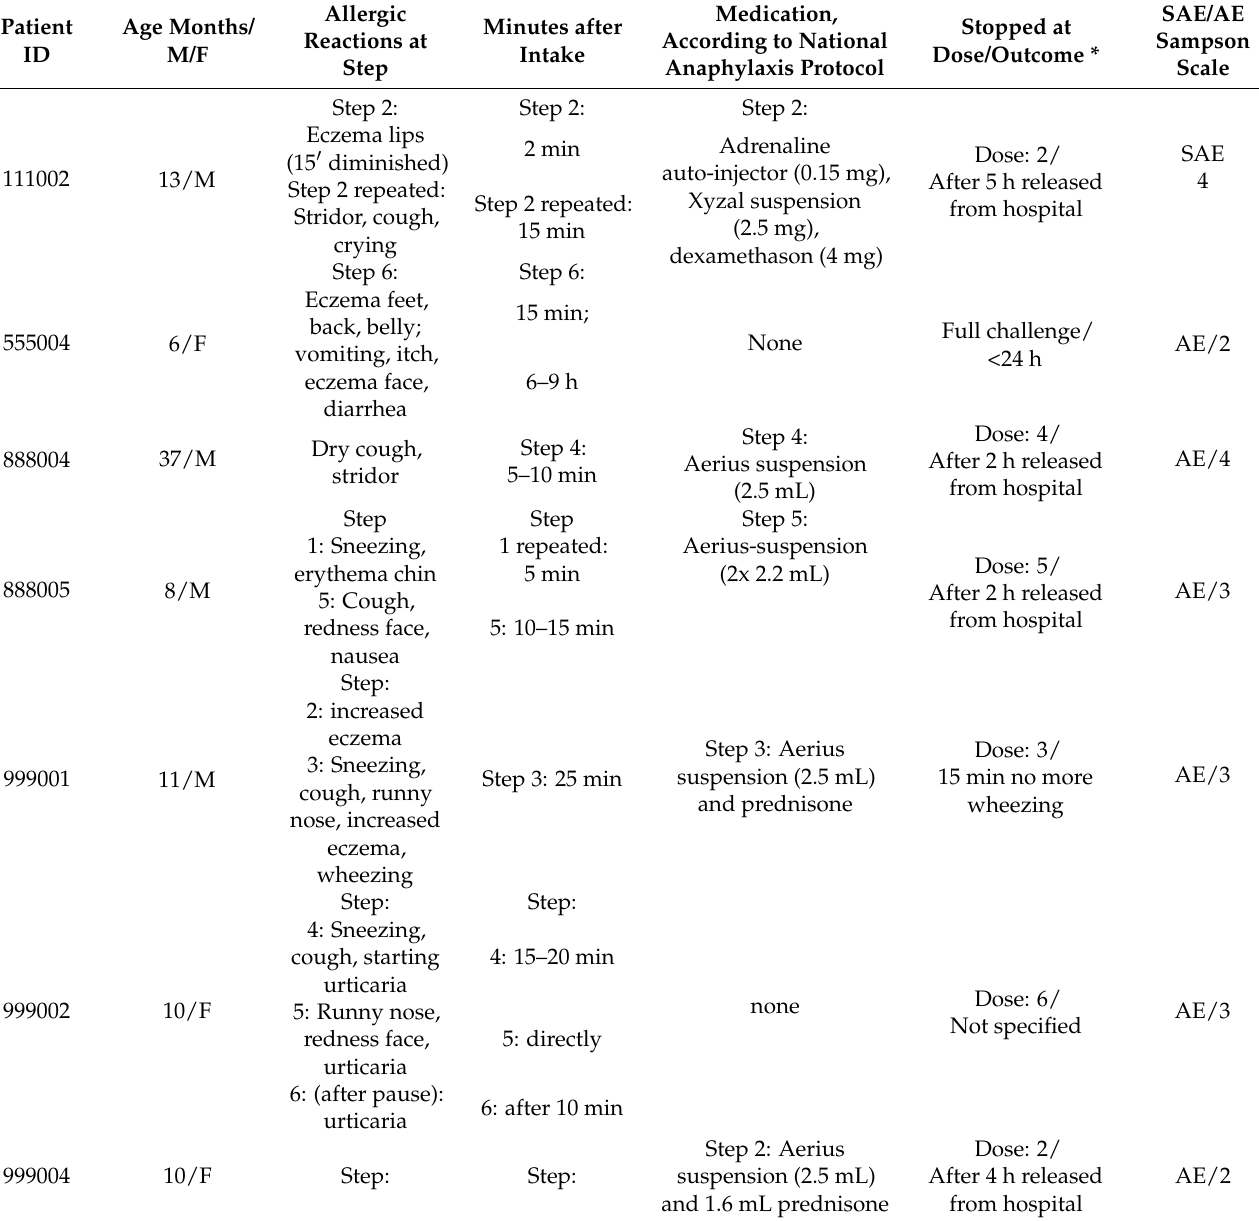
Table 5. Serious adverse events and adverse events